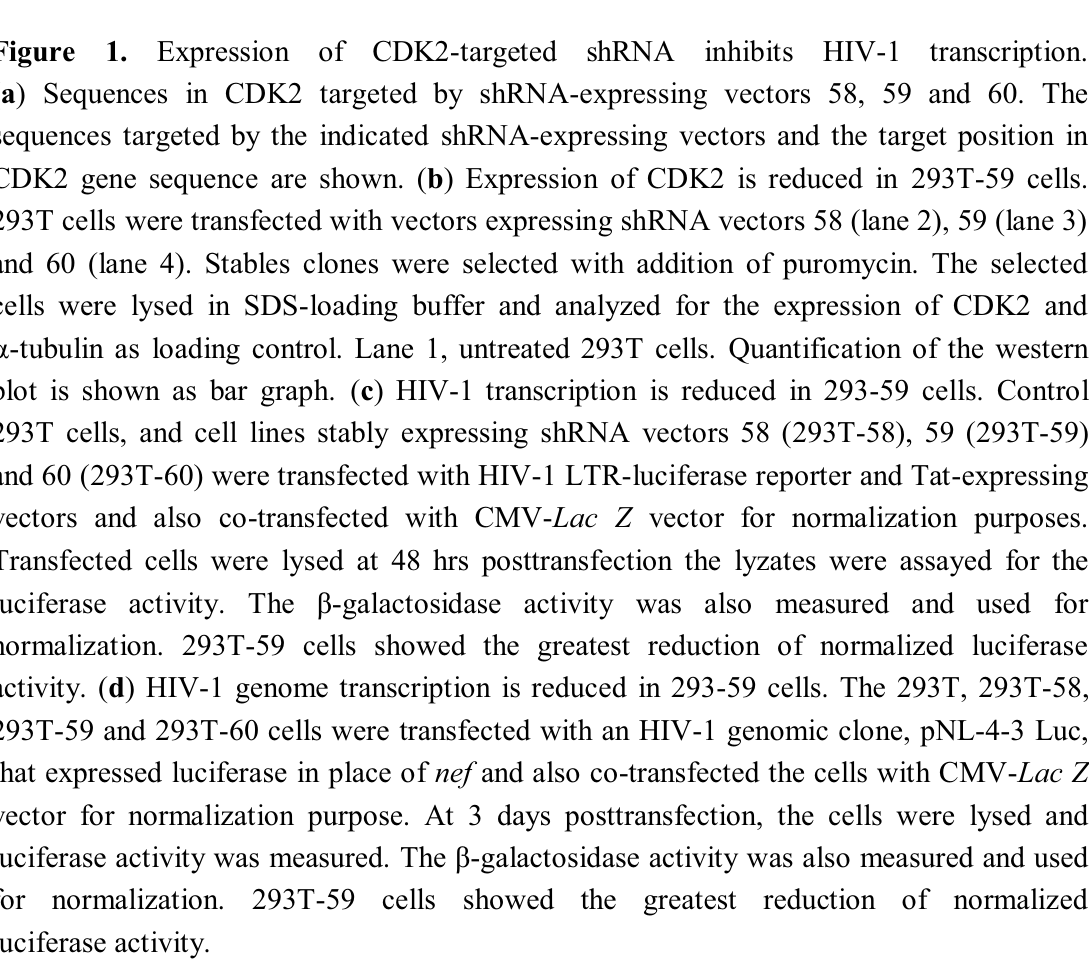
Figure 1. Expression of CDK2-targeted shRNA inhibits HIV-1